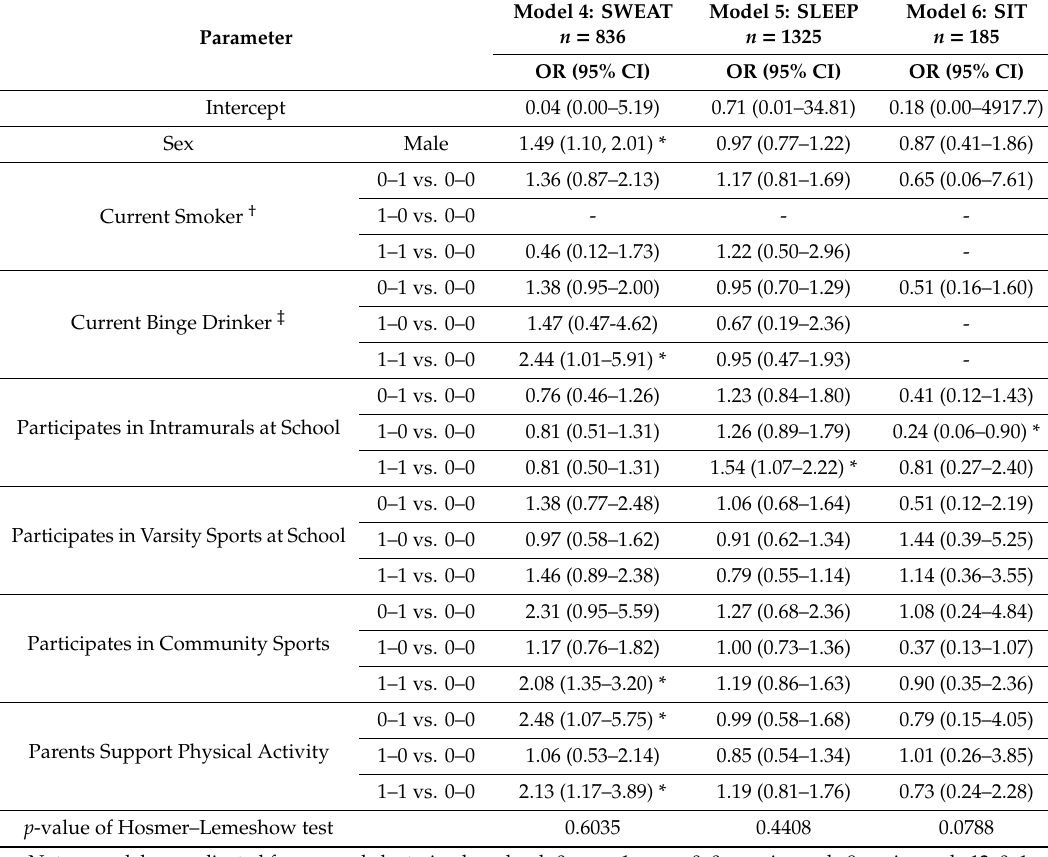
Table 5. Factors associated with meeting the 24-Hour Movement Guideline components in grade 12 among students who were meeting the guideline in grade